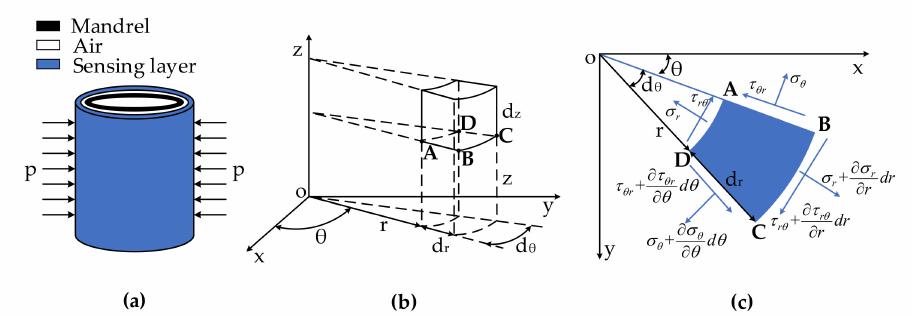
Figure 2. Theoretical modeling of mandrel hydrophone sensor head. ( a ) Pressure model; ( b ) hexahedral element in cylindrical coordinates; ( c ) stress distribution on four sides of hexahedral element in polar